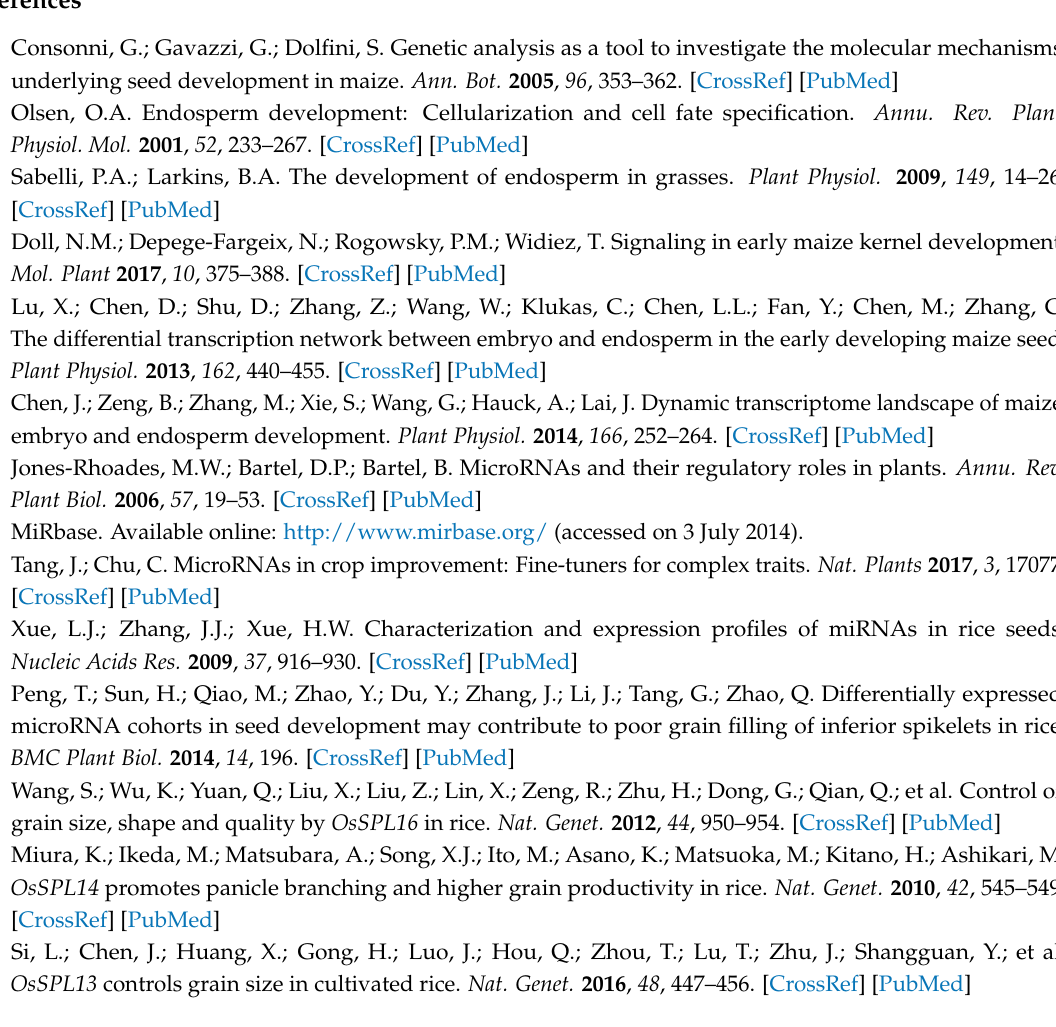
Figure S1: Secondary structures of precursor of six novel maize miRNAs, Table S1: List of primers used in this study, Table S2: Characteristics of all known miRNAs identified in this study, Table S3: Novel miRNAs predicted by miRDeep2, Table S4: Known miRNAs were highly expressed in this study (TPM > 50), Table S5: Target genes of embryo- and endosperm-specific miRNAs, Table S6: GO analysis for target genes of embryo- and endosperm-specific